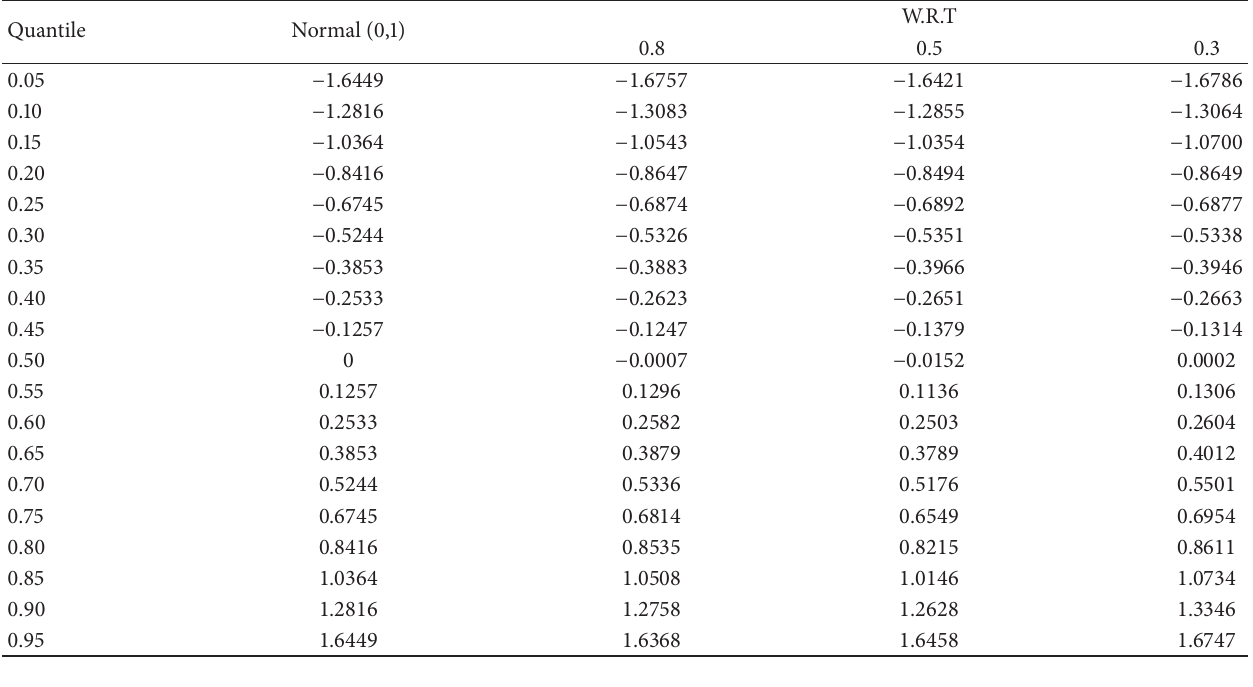
Table 4: The quantiles of W.R.T and 𝑁(0,1) .